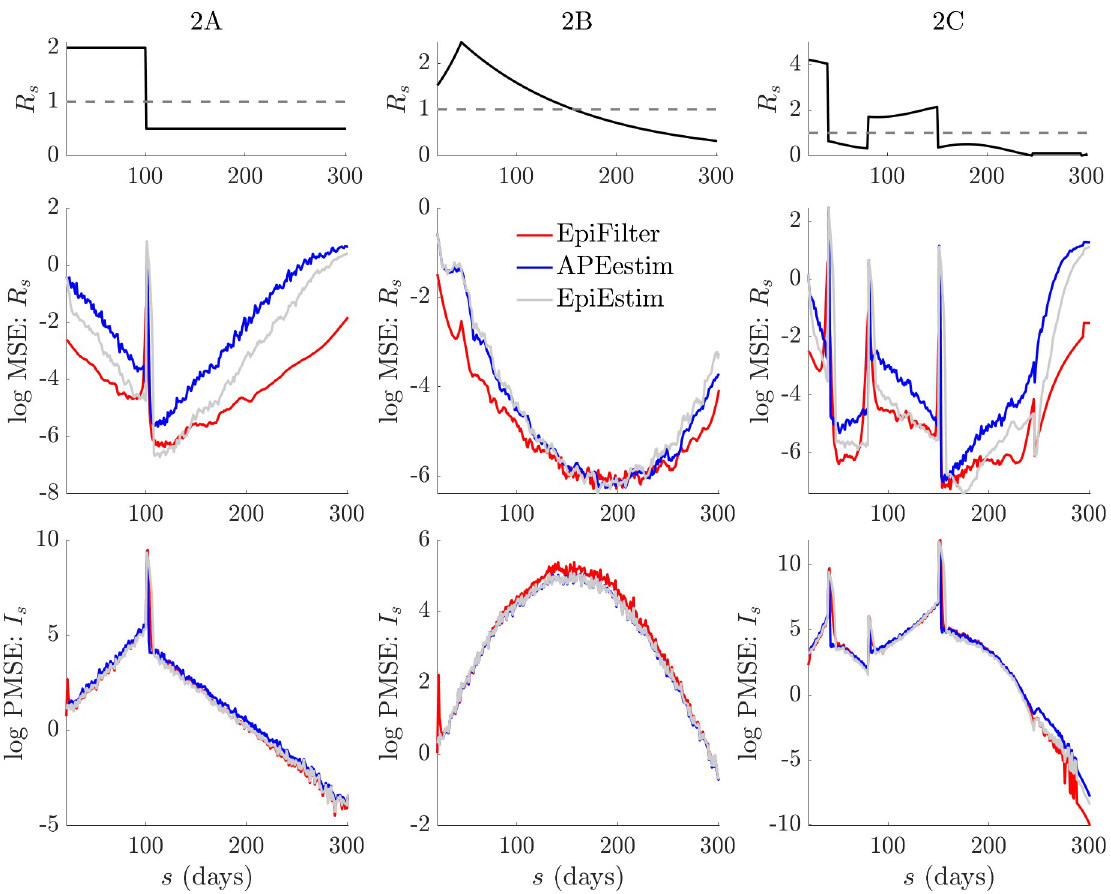
Fig 3. Temporal statistics of small or waning epidemics. We expand on the results from Fig 2D by decomposing the MSE and one-step- ahead PMSE statistics across the 200 simulated trajectories for every scenario in Fig 2. We do not consider the k = 31 EpiEstim example given its poor performance. We present the k = 7 case, which is the generally recommended EpiEstim setting. We observe that EpiFilter significantly improves on MSE throughout the epidemic trajectory (and not only in periods of low incidence) while maintaining comparable prediction accuracies. Coverage statistics for these scenarios, which are given in Fig C of the S1 Appendix, confirm that EpiFilter also consistently contains the true R and I values within its credible intervals. s s